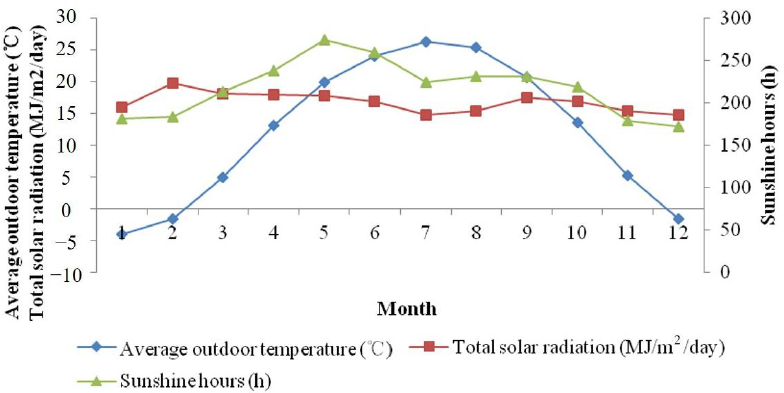
Figure 4. Climate conditions in Tianjin.